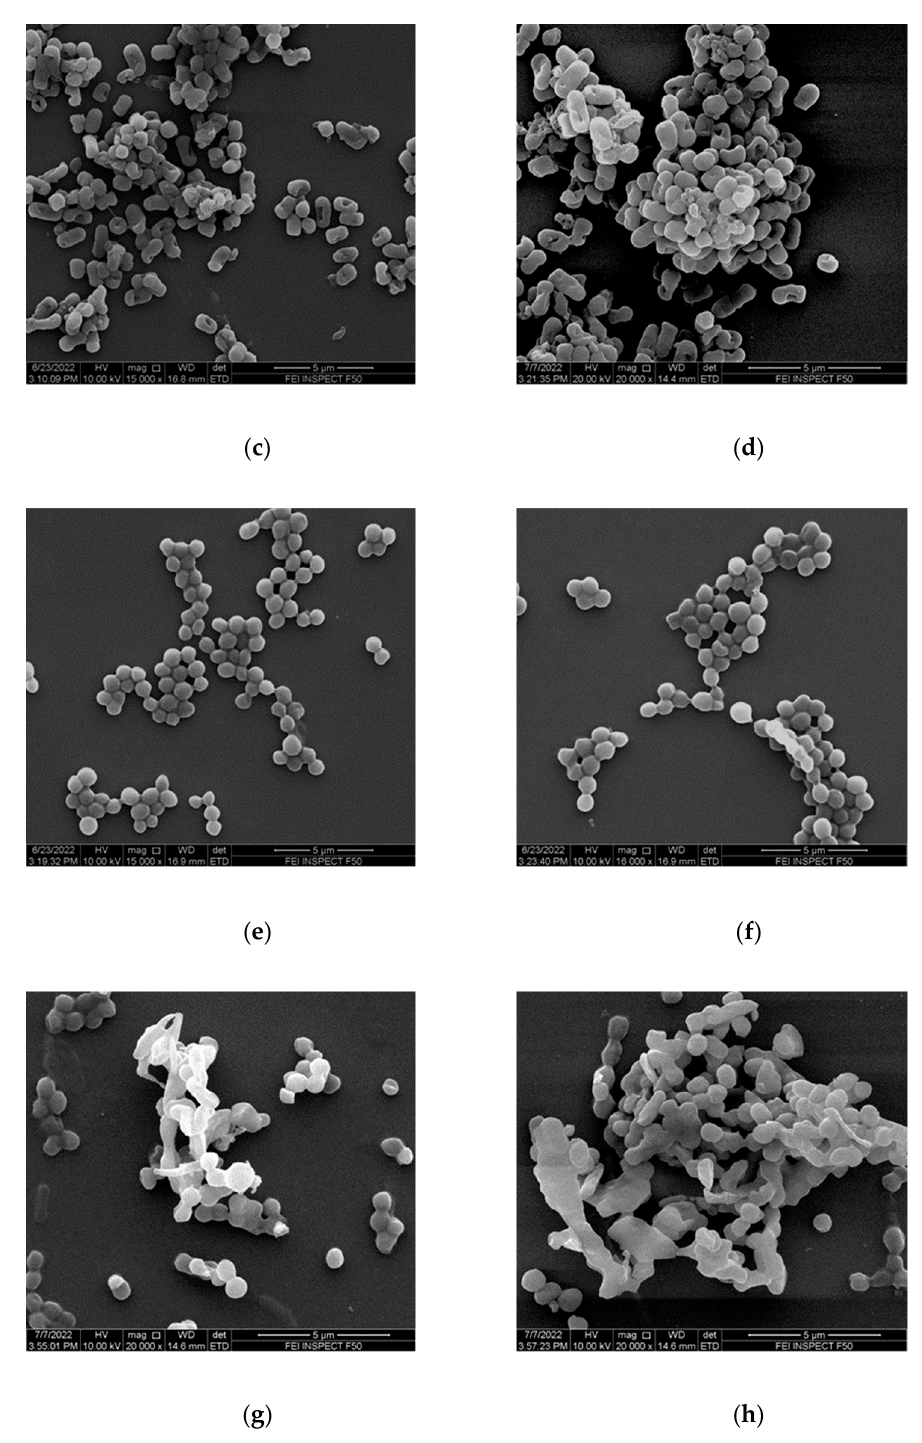
Figure 7. SEM images of E. coli ( a – d ) and S. aureus ( e – h ) that were untreated ( a , e ) and treated with LA-RWR ( b , f ), c-LA-RWR nanoparticles ( c , g ), and LA-RWR-PEA ( d , h ) at 2MIC concentration for 30 min, respectively.